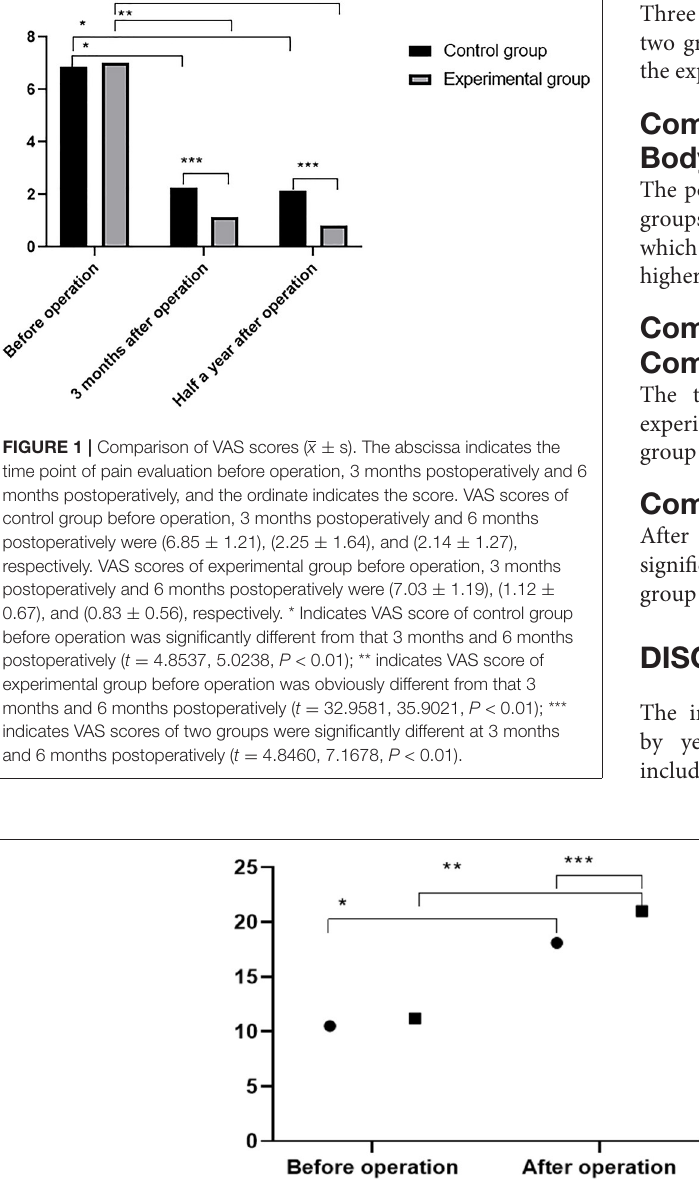
Frontiers in Surgery |